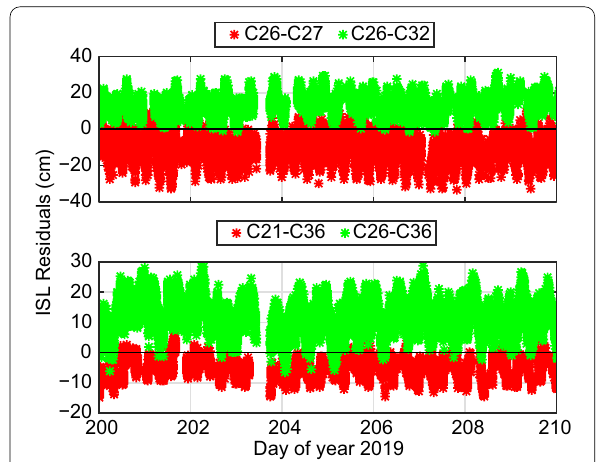
Fig. 8 The post-fit residuals of ISL clock-free observables for C26-C27, C26-C32, C21-C36, and C26-C36